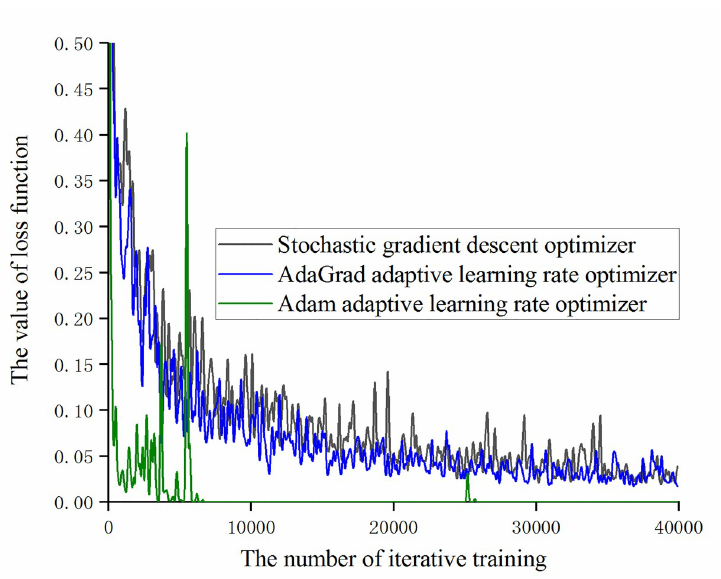
Fig 16. The trend of loss function value with the number of iterative training under different optimizers.